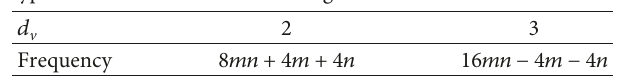
Figure 1: Chemical graph of the benzene ring embedded in a P- type surface network in Table 2: Vertex partition of the benzene ring embedded in the P- type surface network based on degrees of each vertex.